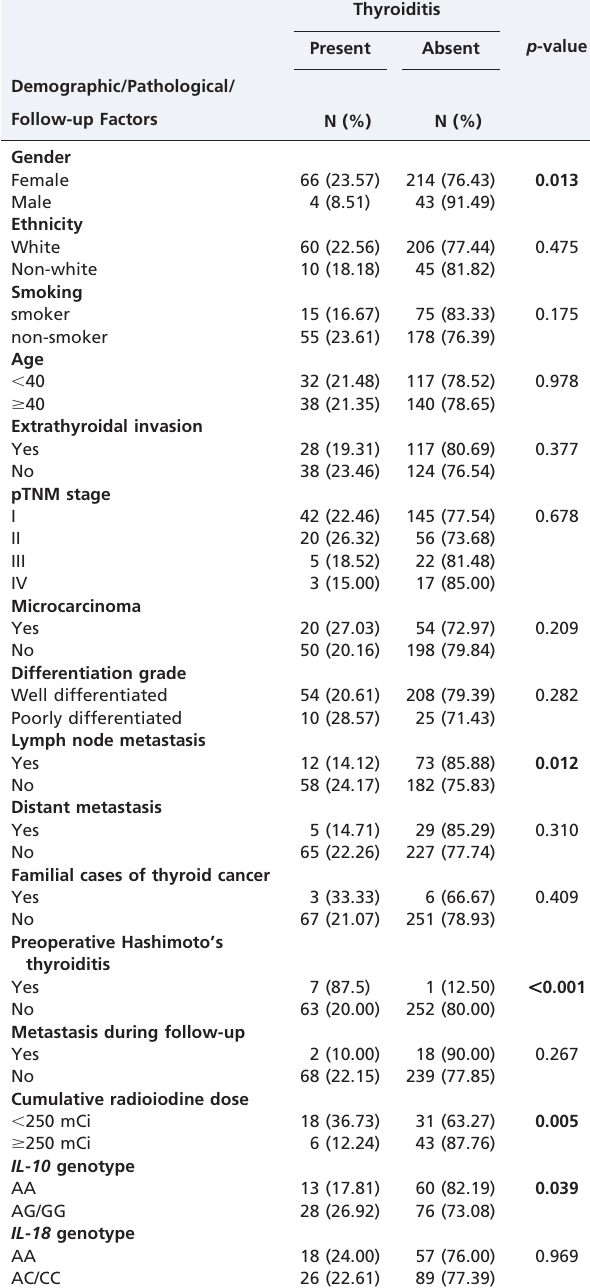
Table 2 - Demographics, pathological features and follow-up characteristics of 327 differentiated thyroid carcinoma patients presenting concurrent lymphocytic thyroiditis (N = 70 patients) or not (N =257 patients). The data were obtained using a multivariate regression analysis. IL = interleukin; N= absolute number of